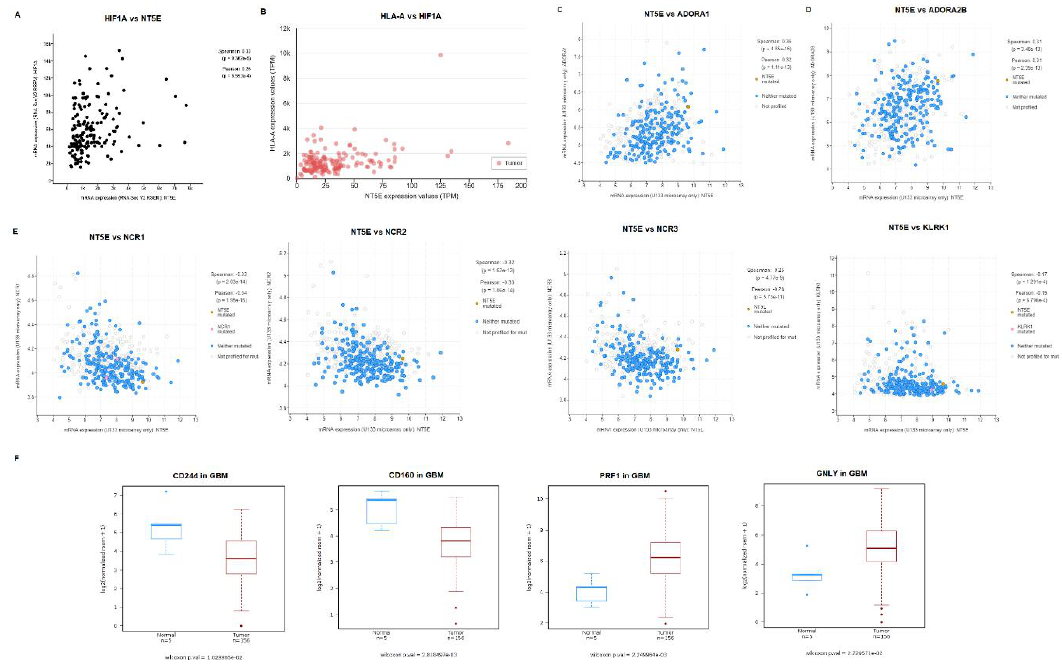
Figure 3. Correlation of expression of NT5E and NK gene signatures in GBM. ( A ) Co-expression of NT5E and HIF1A in GBM. Data were analyzed in cBioPortal using U133 Affymetrix microarray data (z = 1; n = 533). ( B ) Co-expression of NT5E and HLA-A based on TCGA data in UALCAN ( n = 156). ( C ) Co-expression of NT5E and ADORA1 in GBM using the TCGA database analyzed in cBioPortal on the basis of U133 Affymetrix microarray data (z = 1; n = 533). ( D ) Co-expression of NT5E and ADORA2B in GBM using the TCGA database analyzed in cBioPortal on the basis of U133 Affymetrix microarray data (z = 1). ( E ) Co-expression of NT5E and genes representing NK activating receptors: NCR1 , NCR2 , NCR3 , and KLRK1 in GBM. Data were analyzed in cBioPortal using U133 Affymetrix microarray data (z = 1). ( F ) Box-plots of the expression of genes associated with NK cells in GBM (red) and normal tissue (blue): CD244 , CD160 , PRF1 and GNLY based on TCGA data analyzed in TCGA Wanderer ( n = 156).